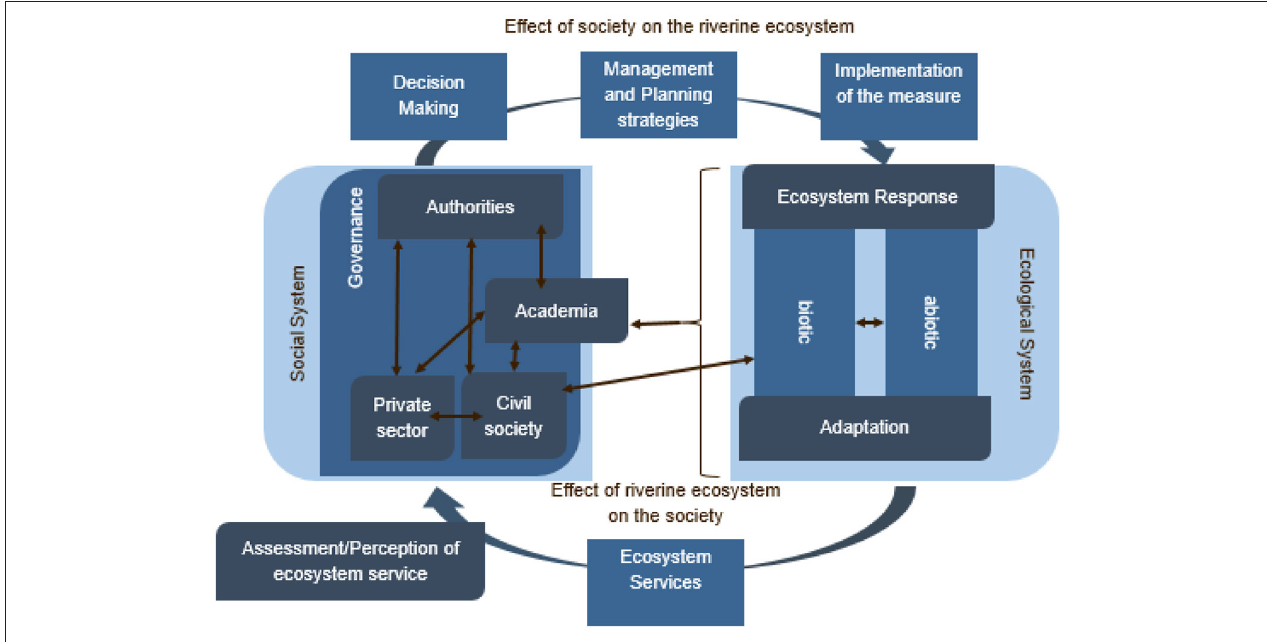
FIGURE 1 | Theoretical framework of the socio-ecological river